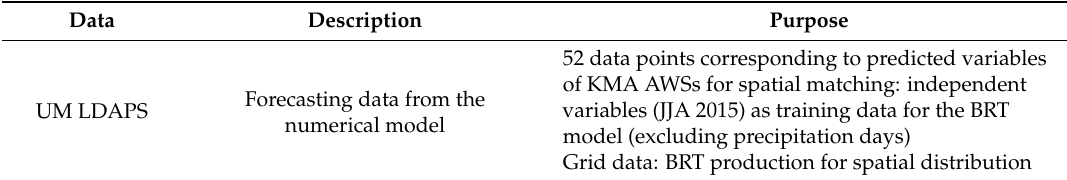
Table 3. The purpose and description of the dataset used in the development and evaluation of the Building-scale Resolved air Temperature (BRT)